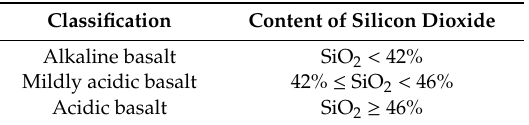
Table 2. Classification of basalt. (Adapted form Soares et al. 2016 [19]).